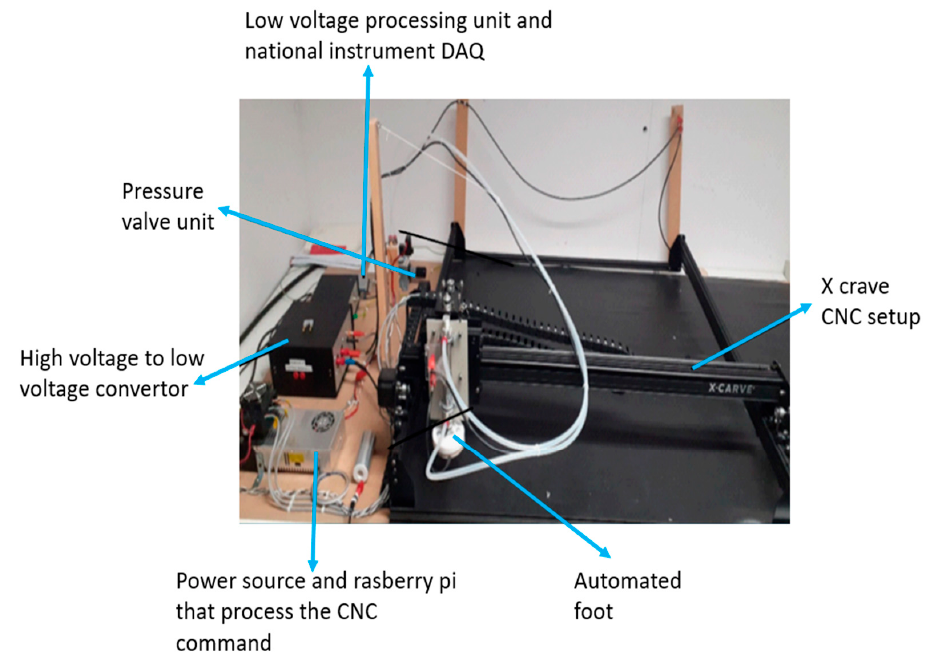
Figure 2. Different parts of setup for electrostatic characterization of textiles.